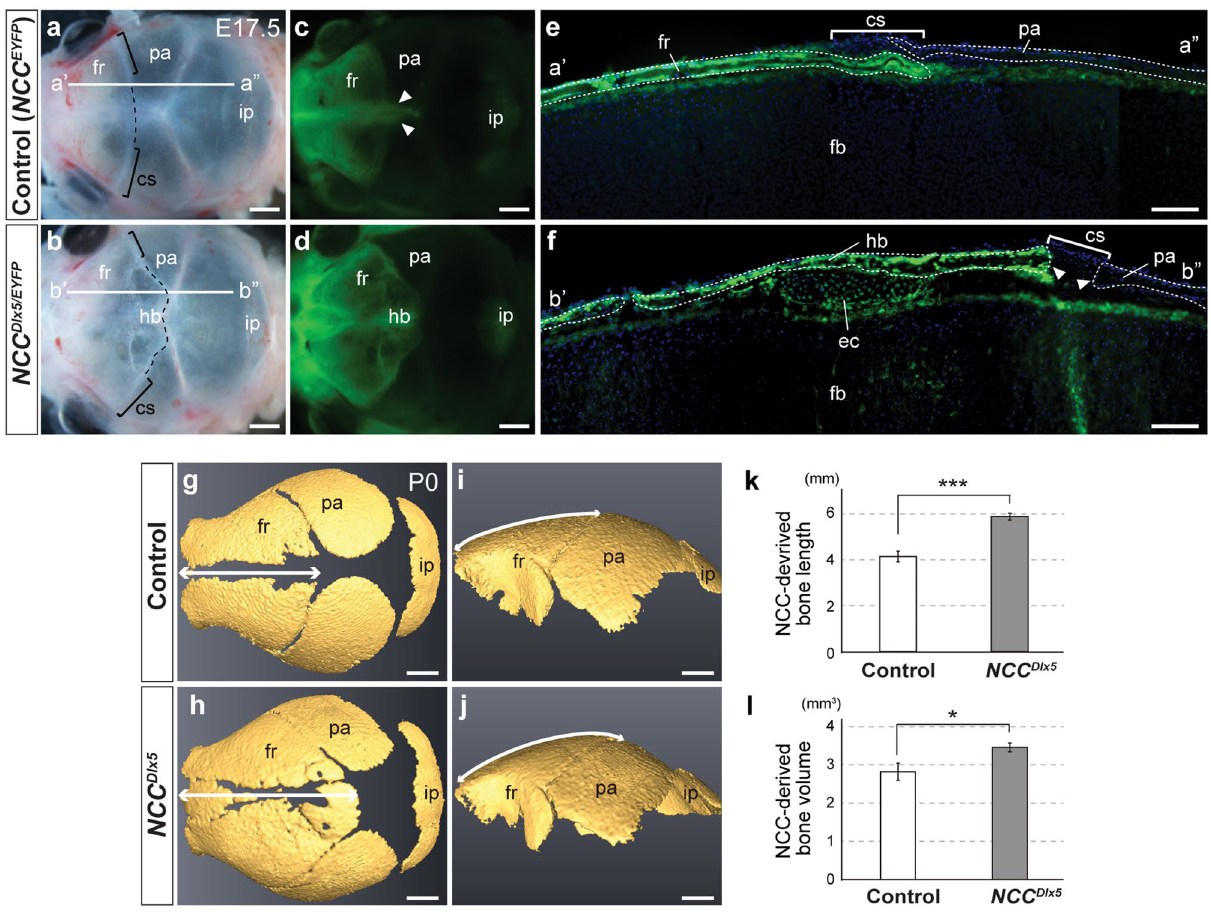
Figure 3. Ectopic cartilage and heterotopic bone in the NCC Dlx5 formed in NCC-derived head mesenchyme. Skull vault of E17.5 NCC EYFP ( a , c , e ) and NCC Dlx5/EYFP ( b , d, f ) with brightfield ( a , b ) and fluorescent ( c – f ) images. ( c ) and ( d ) are the fluorescent images of ( a ) and ( b ), respectively. Green fluorescence implies NCC originating cells. Brackets and dashed lines in dorsal views ( a, b ) indicate the coronal suture at the lateral side and the prospective coronal sutures at the apex, respectively. Arrowheads in ( c ) point to the “NCC tongue” between the parietal bones. ( e , f ) Parasagittal sections of the control ( NCC EYFP ) and mutant ( NCC Dlx5/EYFP ) at planes indicated in ( a ) (a’–a’’) for ( e ) and ( b ) (b’–b’’) for ( f ). Nuclei are counterstained by Hoechst. Brackets and arrowheads in ( e , f ) indicate the coronal sutures of the control and the opened end-to-end junction at the coronal suture of the mutant, respectively. ( g – j ) μCT images of calvarial bone of the control ( g , i ) and the NCC Dlx5 ( h , j ) at P0. Double-head arrows in ( g – j ) demonstrate the NCC-derived bone length to be measured. ( k, l ) Statistical analyses of NCC-derived bone length ( k ) and volume ( l ) (n = 3). Two-tailed t-test, *p < 0.05; ***p < 0.001. cs, coronal suture; ec, ectopic cartilage; fr, frontal bone; hb, heterotopic bone; ip, interparietal bone; pa, parietal bone. Scale bars; 1 mm ( a – d, g – j ) and 100 μm ( e , f